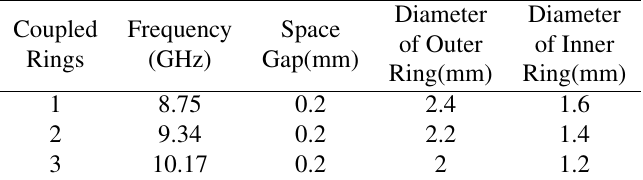
Table 1: Parameter and frequency values of 3 (cid:0)